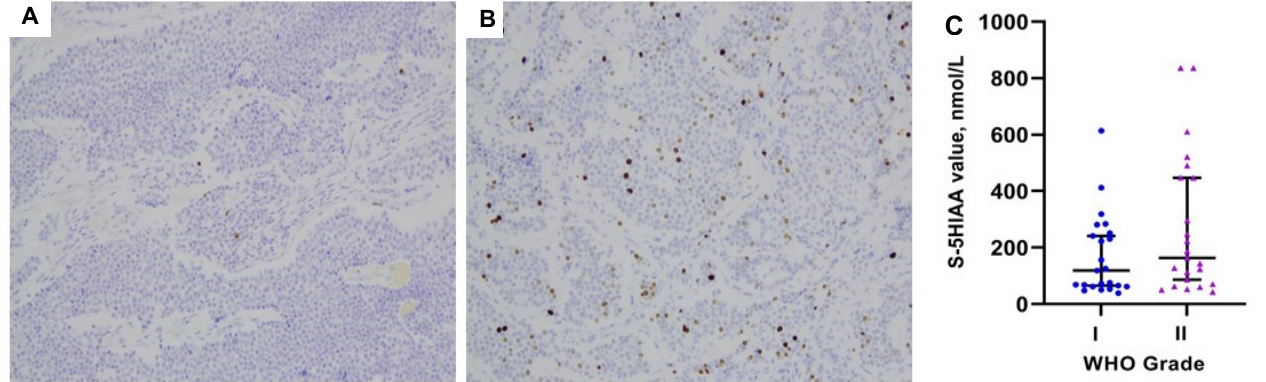
Figure 3. ( A ) Low Ki67 staining of a primary tumor in the distal ileum from a patient with a low-proliferative small intestinal neuroendocrine neoplasm (SI-NEN) in the study cohort. ( B ) High Ki67 staining from another patient with SI-NEN in our study cohort, also located in the distal ileum. ( C ) Scatter plot of serum 5HIAA values (median with 95% CIs) in patients with grade I (Ki67 < 3%) vs. grade II tumors (Ki67 3–20%; p = 0.174). Two outliers are not presented because their data points were outside the range of the y axis. The excluded values were: 3199 and 2076 nmol/L; both cases had grade II disease.